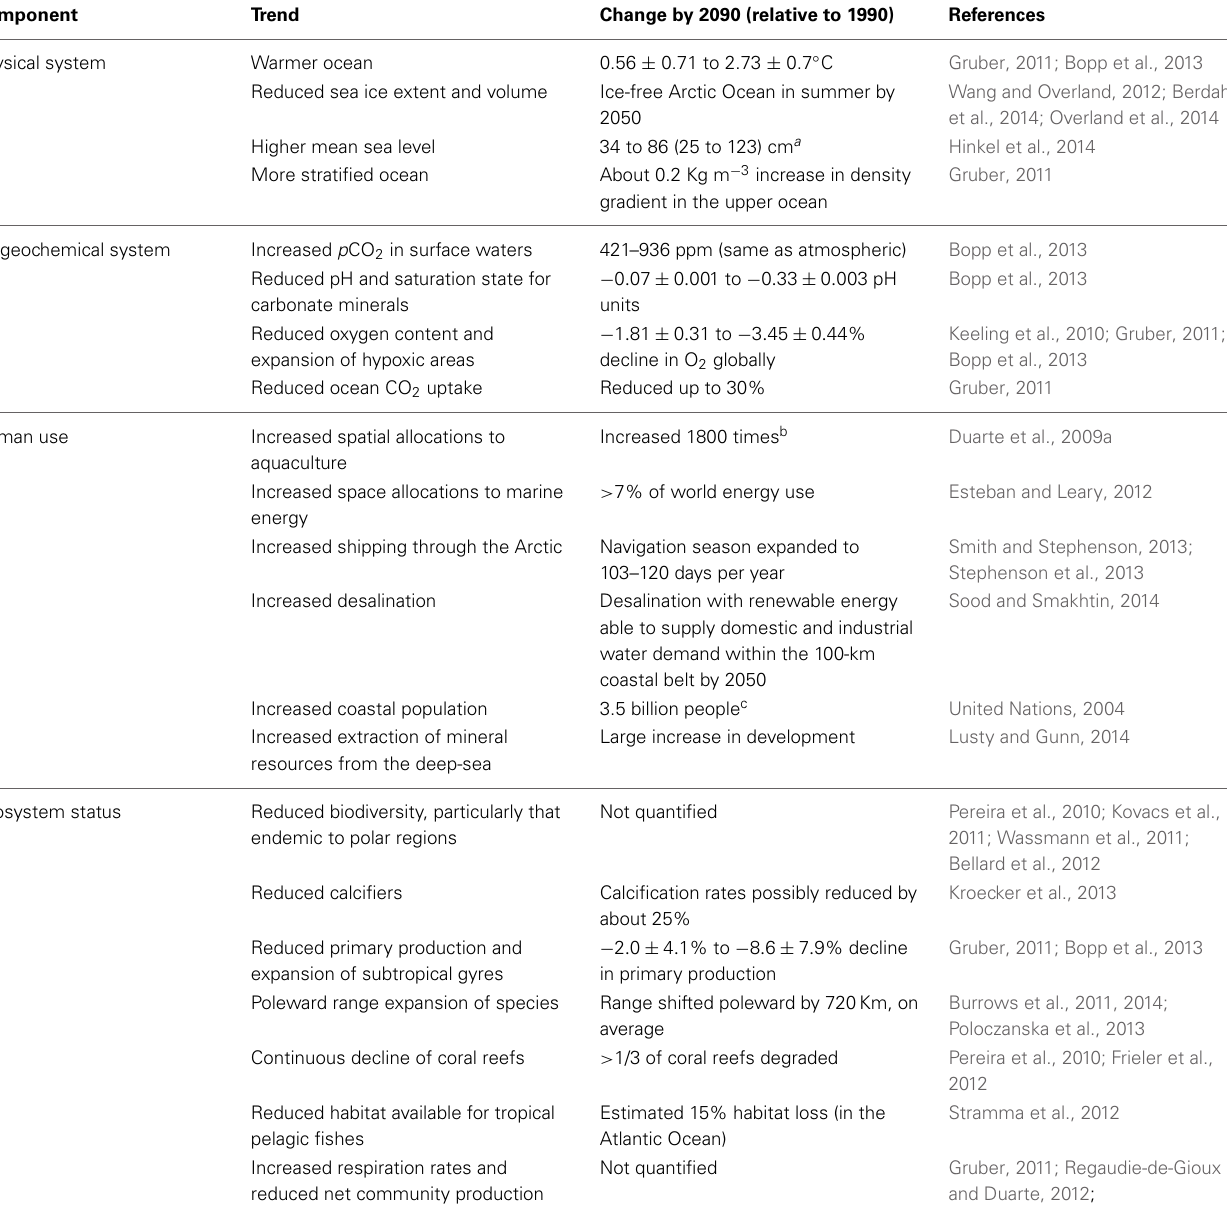
Table 1 | Qualitative and quantitative forecasts for a future